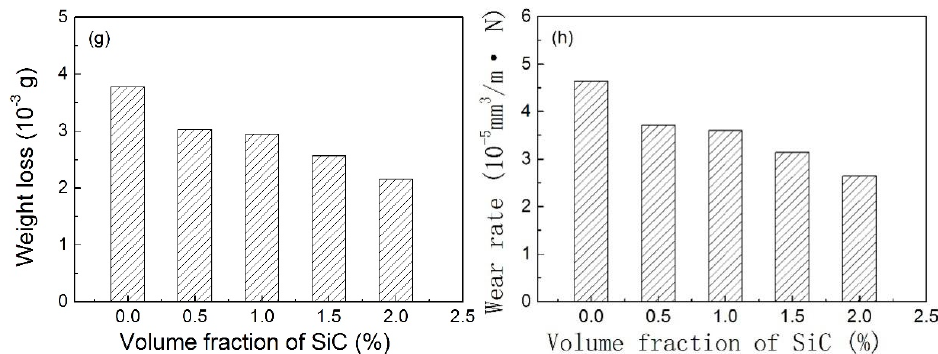
Figure 15. Friction coefficient, weight loss and wear rate of the rheoformed composite parts with different volume fraction of SiC particles: ( a ) 0, ( b ) 0.5%, ( c ) 1.0%, ( d ) 1.5%, ( e ) 2.0%, ( f ) average friction coefficient, ( g ) weight loss and ( h ) wear rate.